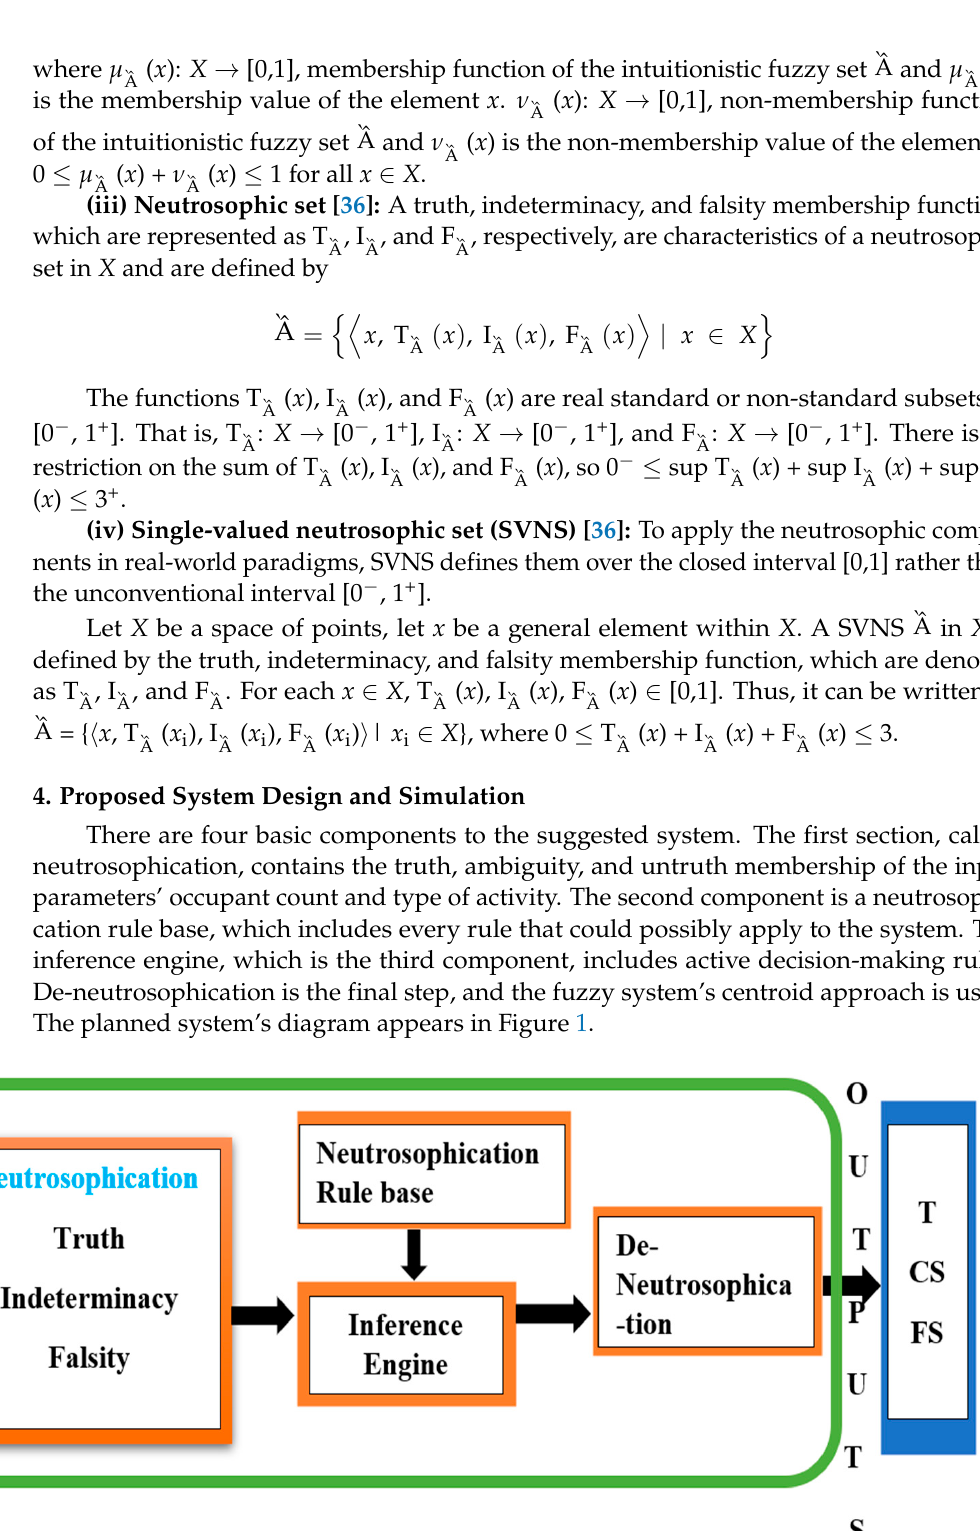
Figure 1. Diagram of the planned system.